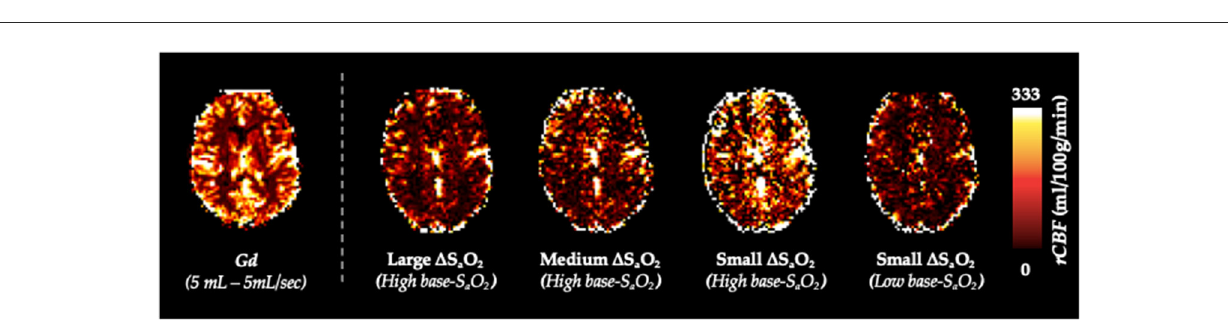
FIGURE7 rCBF Dependency on 1 S a O 2 and Base-S a O 2 . rCBF (mL/100g/min) maps from representative subject axial slice where tissue is normalized to an arterial voxel in the MCA for five subsequent paradigms (left to right): standard Gd, large 1 S a O 2 with high base-S a O 2 , medium 1 S a O 2 with high base-S a O 2 , small 1 S a O 2 with high base-S a O 2 , small 1 S a O 2 with low base-S a O 2